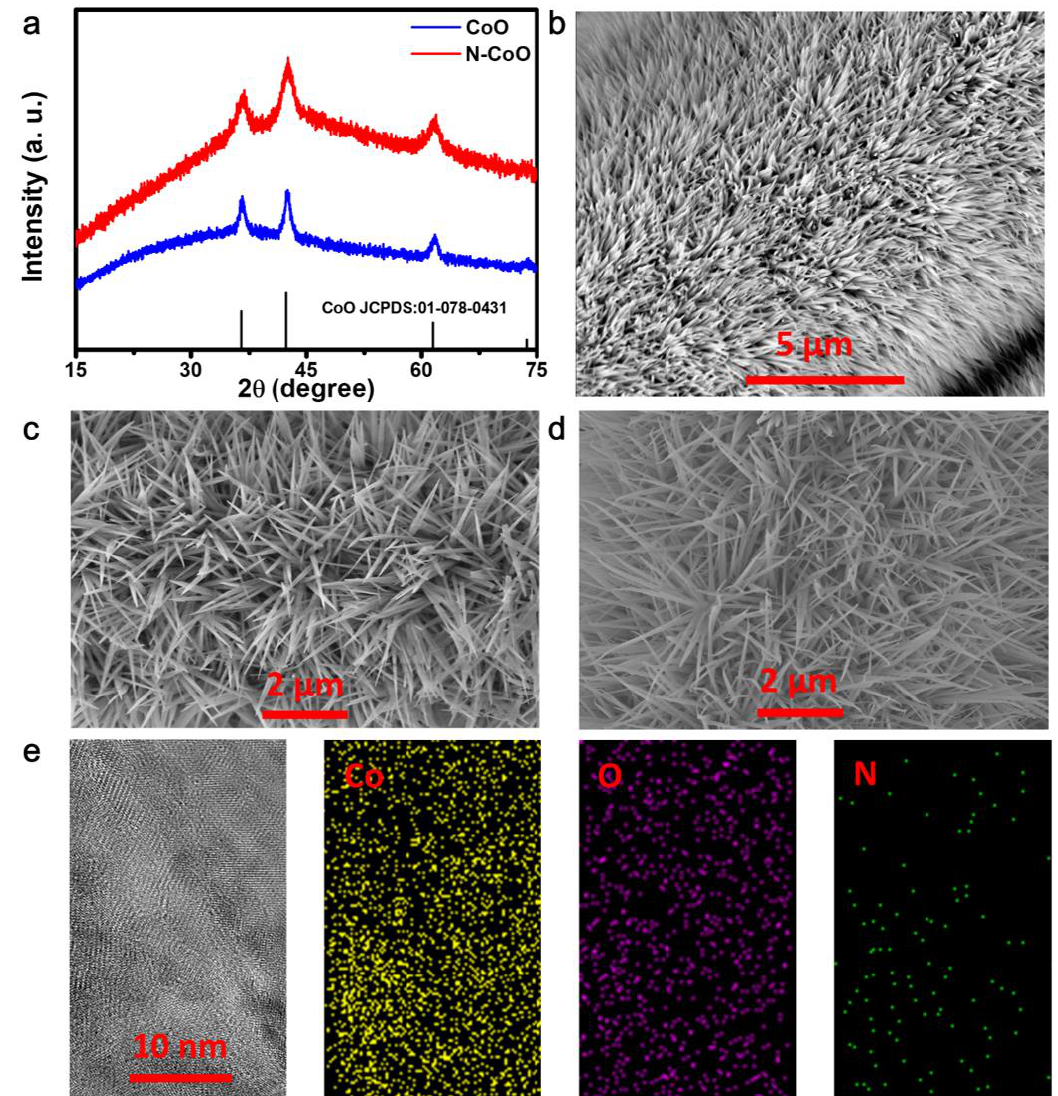
Figure 2. ( a ) XRD patterns of CoO and N-CoO nanowire arrays. ( b – d ) SEM images of Co x (OH) y , CoO and N-CoO nanowire arrays. ( e ) Element mappings of Co, O and N in N-CoO nanowire arrays.